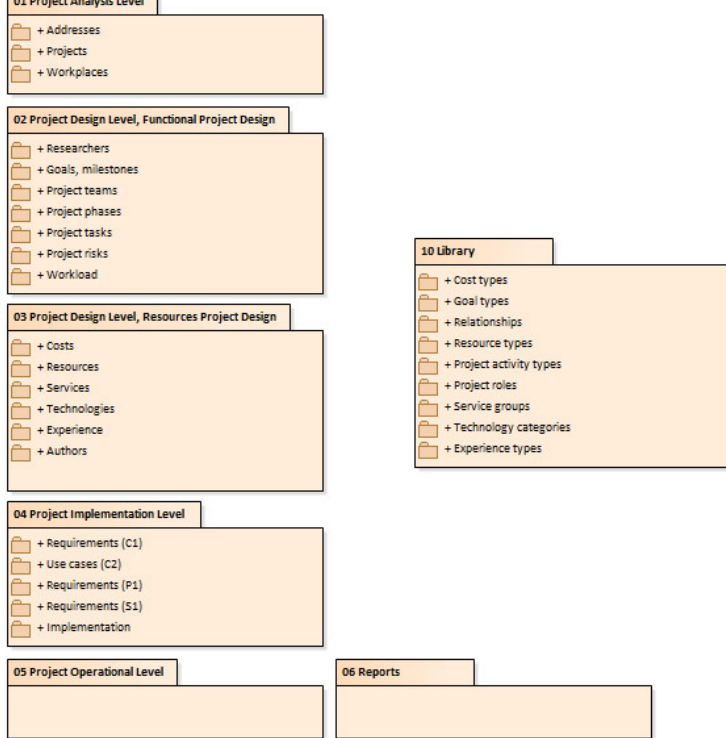
Figure 18. ResearchML project design template.